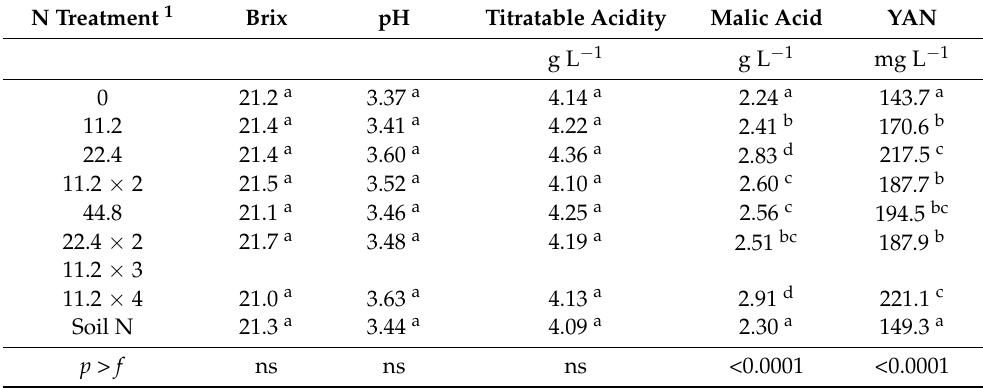
Table 4. Foliar and soil applied N effects on selected wine grape quality parameters in 2015 (site A) 1 . N Treatment